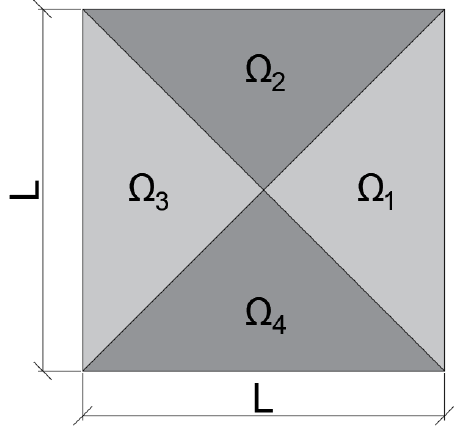
Figure 3. Partition of Ω into four portions.